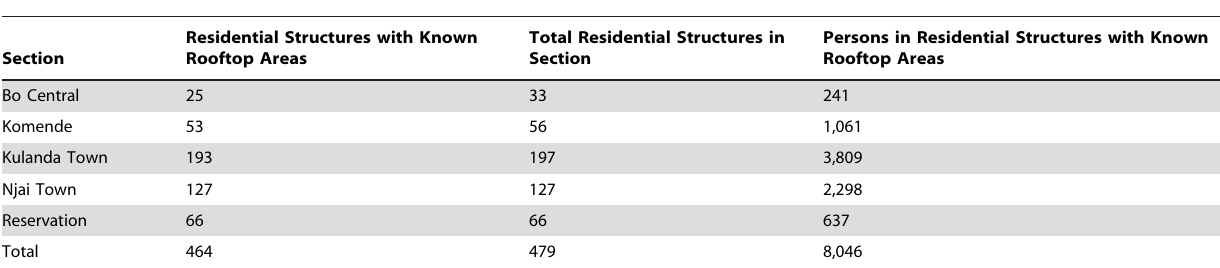
Table 2. The subset of Bo residences with known occupancies and rooftop areas.